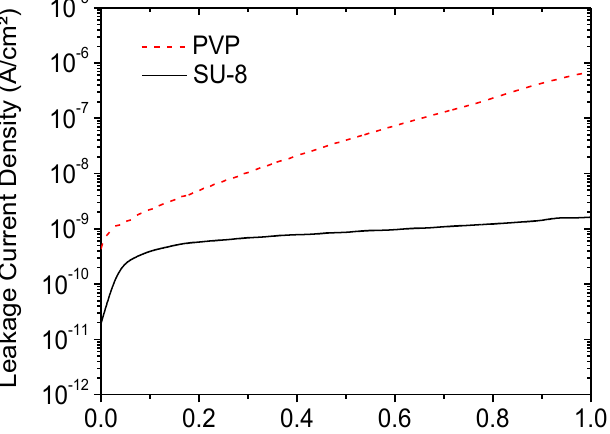
Figure 3. Comparison of leakage current densities for PVP and SU-8